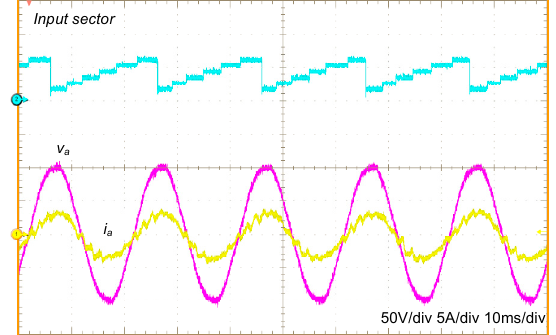
Figure 16. Experimental results of input side. Appl. Sci. 2019 , 9 , x FOR PEER REVIEW